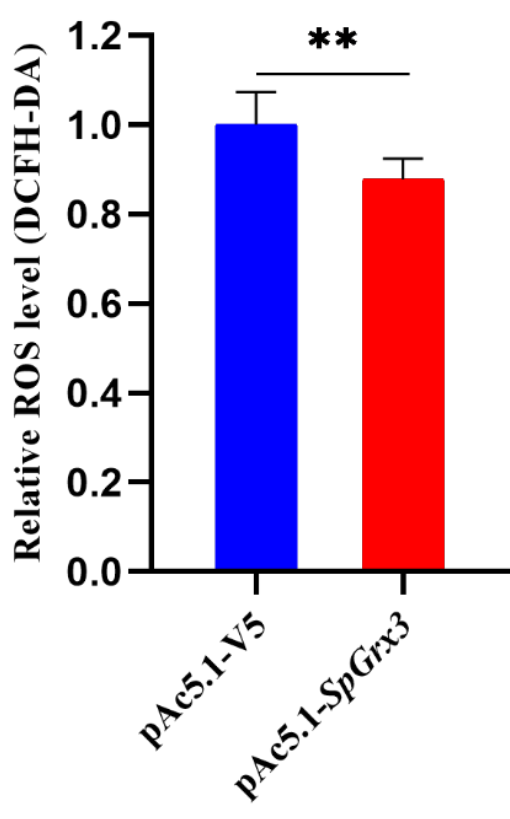
Figure 8. Relative ROS levels in S2 cells. After transferring the empty pAc5.1-V5 vector or the pAc5.1- SpGrx3 expression plasmid into S2 cells for 24 h, cells were incubated in a hypoxic chamber (1% O2) for 24 h. The ROS levels were then detected by DCFH-DA staining as described in the methods. The data are presented as the mean ± SD (N = 3). **: p < 0.01.